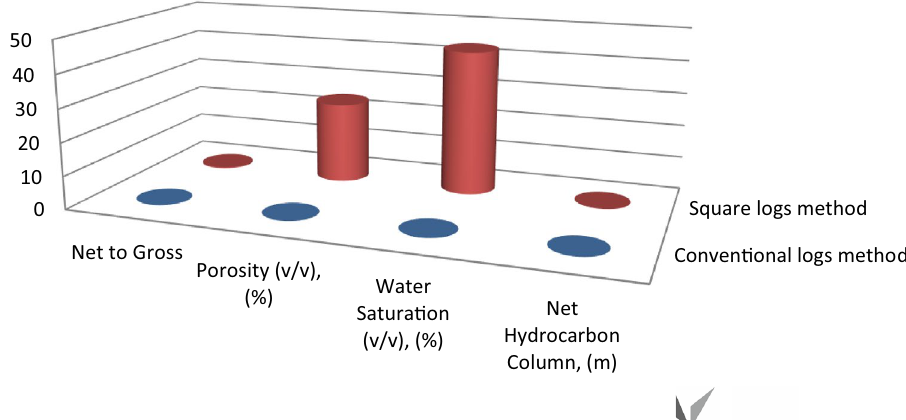
Fig. 14 Petrophysical param- eter with consideration of the NISOC cutoffs